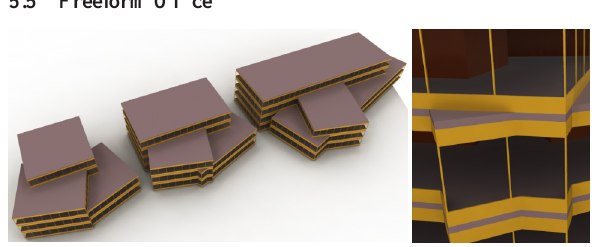
Figure 15: Office rectangular, L-shape and atrium buildings.